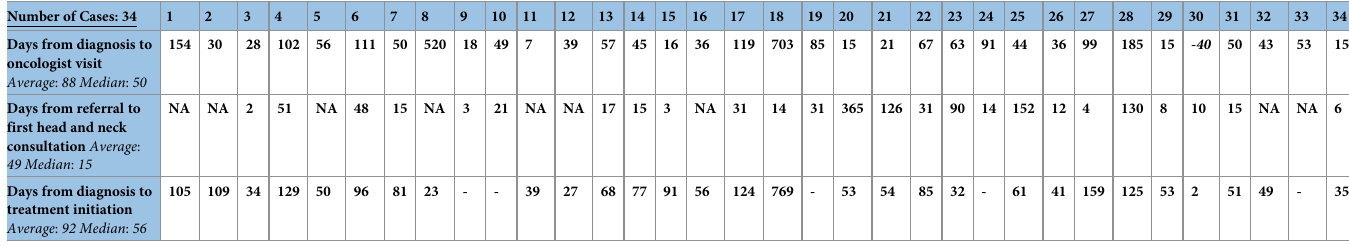
Patient factors (biological, behavioural and sociodemographic). Our findings captured multiple risk factors reported by patients in this study. This risk factors are categorized as bio- logical , such as having a past history or a family history of cancer along with comorbidities; behavioural , such as a long history of smoking tobacco/recreational drugs and alcohol con- sumption. Patients with risk factors are at higher risk for developing cancer and should be a priority for preventive screening to avoid delay; and sociodemographic , such as older age, living alone, being divorced/never married, and low socioeconomic status. For example, case 2 was a male with a 37-year history of tobacco and alcohol consumption and his mother died of carci- noma of the stomach. These accumulated factors positioned him at high-risk for developing oral malignancy. Case 11, on the other hand, had a history of divorce and lived alone for 34 years. He also had asbestos exposure and his mother died of lung cancer. A combination of biological and sociodemographic factors increased his risk for cancer.